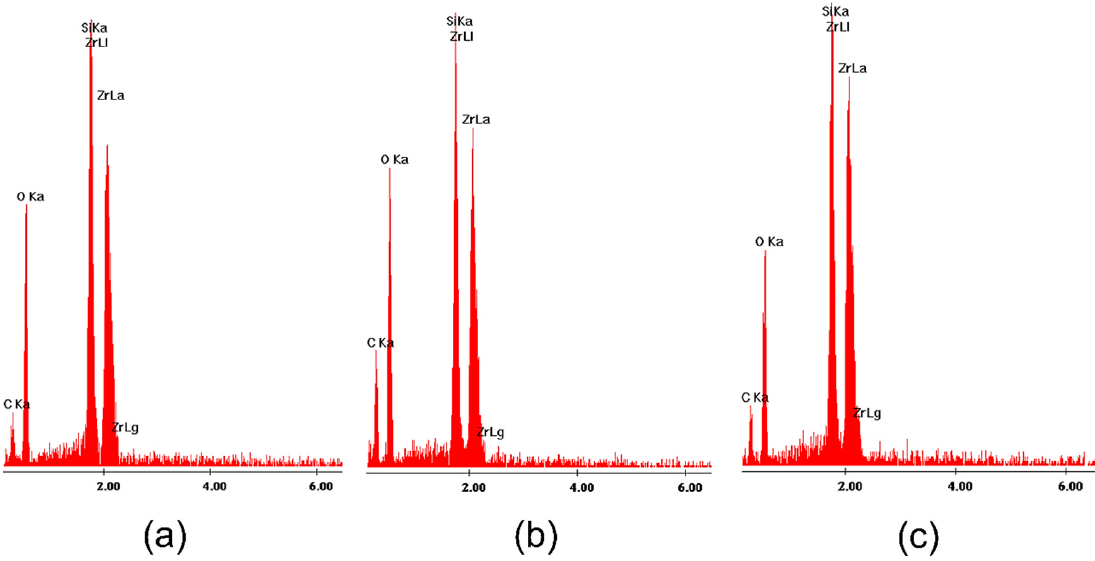
Figure 8 . EDS analysis of 1T gel annealed at 1200 °C in the air (Figure 7a) at: ( a ) point 1; ( b ) at point 2 and ( c ) at point 3.